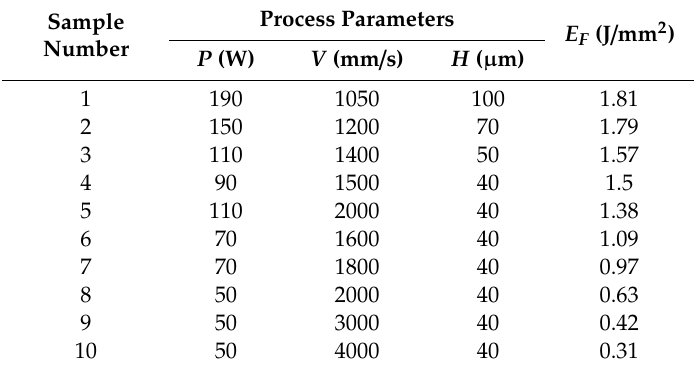
Figure 3. Schematic diagram of ( a ) the dimensions of overhanging structure parts and ( b ) the scanning strategy of lower surface. Table 2. Process parameters of lower surface.